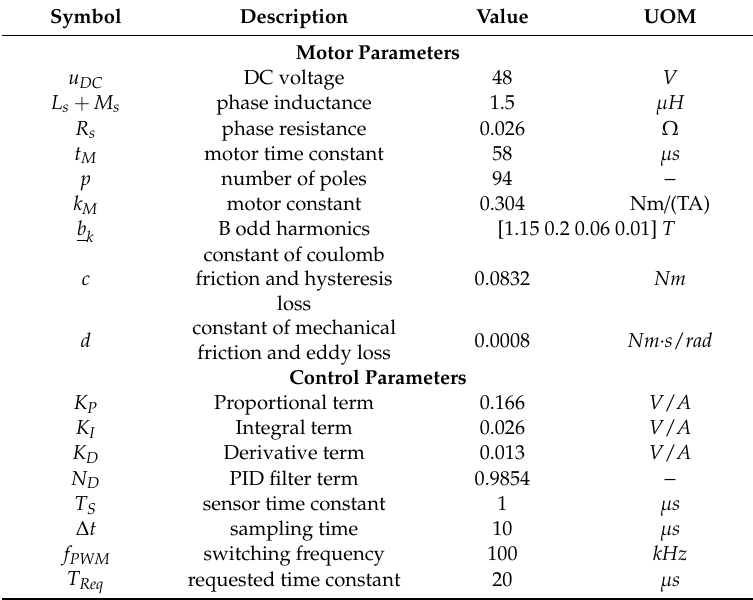
Table 1. Air gab winding wheel-hub motor parameters [17,18].